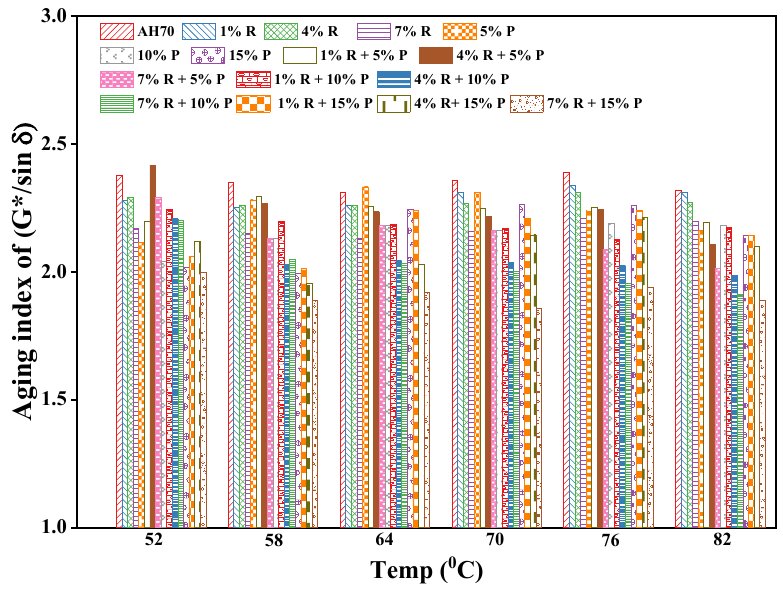
Figure 10. Aging index of (G*/sinδ).